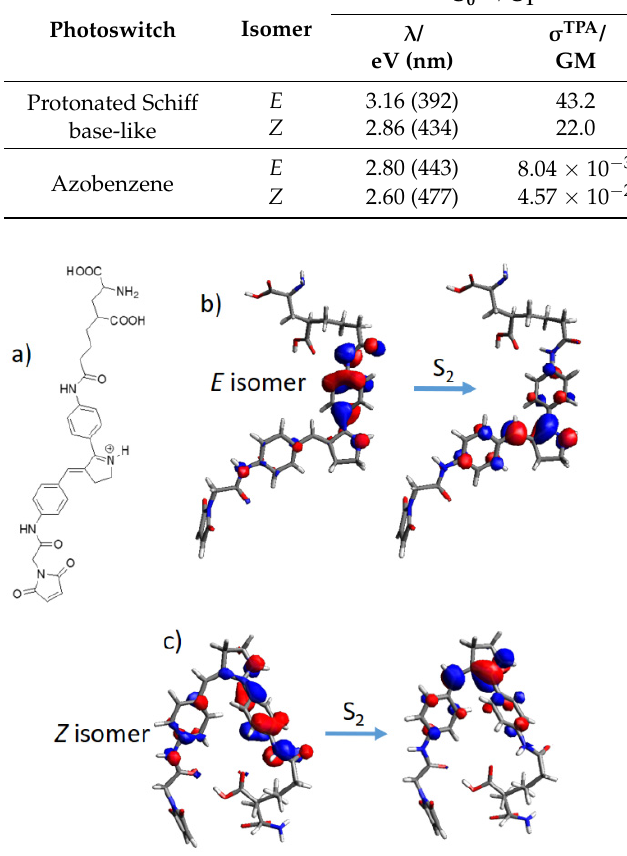
→ S 0 2 electronic